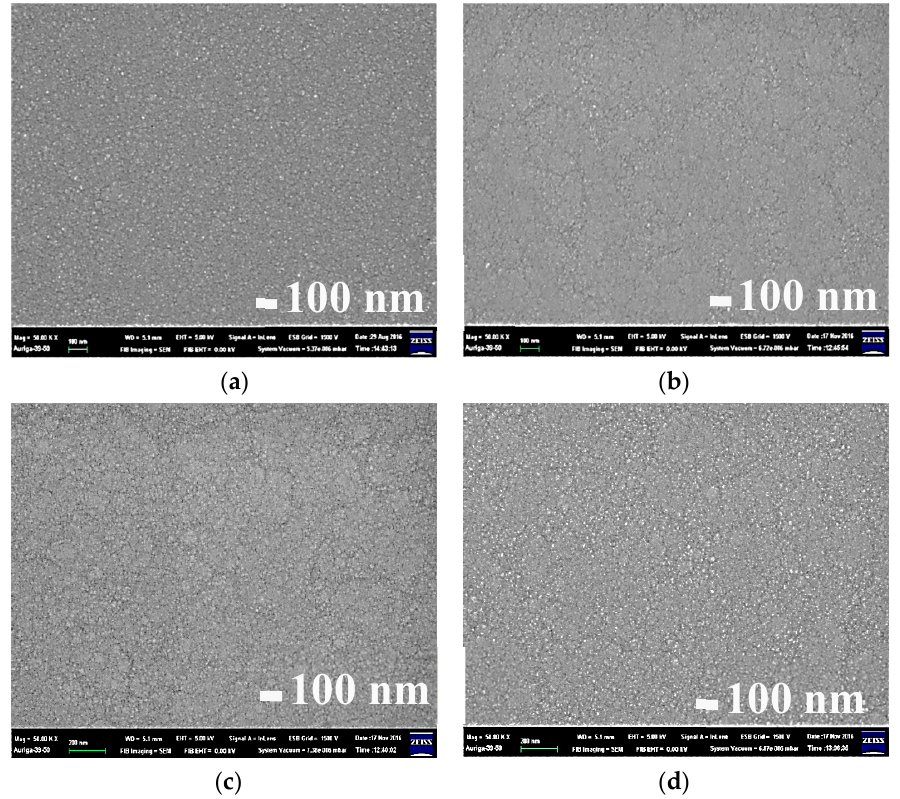
Figure 3. Surface morphologies of electrochromic films: ( a ) WO 3 ; ( b ) LW1; ( c ) LW2; ( d ) LW3.